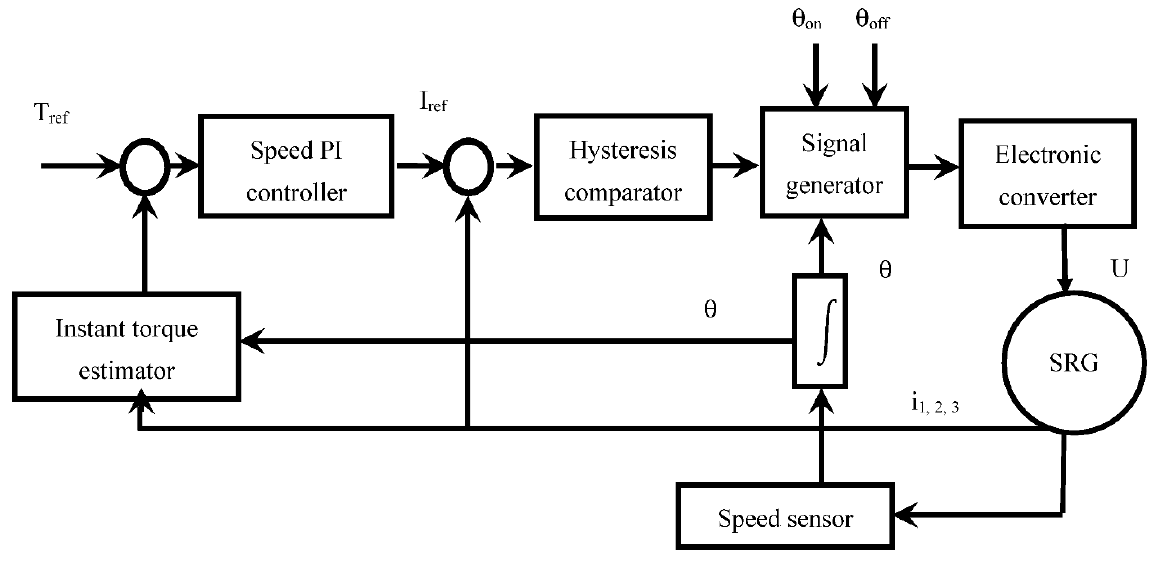
Figure 11. Proposed hysteresis control current with torque control loop.